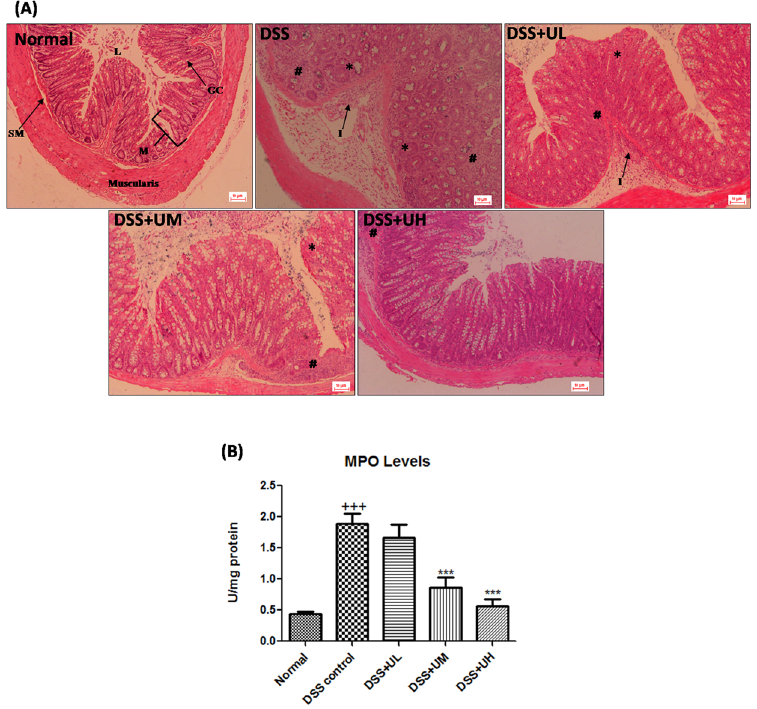
Figure 4. Effect of uridine treatment on the histopathological changes and myloperoxidase (MPO) activity of the colon tissue. ( A ) Representative images of hematoxylin and eosin staining of colon tissue from each group taken at 100x magnification. Colon tissue from Normal group did not show any pathological modification, DSS- induced colon tissue injury was associated with partial destruction of the epithelial architecture such as loss of crypts and epithelial integrity, submucosal edema and intense infiltration of inflammatory cells. Treatment with different dosages attenuated the injury of colon tissue in dose dependent manner. L, Lumen; GC, Goblet cells; M, Mucosa; SM, Submucosa; I, Inflammation; asterisk ( * ) indicates area of goblet cell depletion and distortion of crypt architecture; number sign (#) indicates cellular infiltration. ( B ) The myloperoxidase (MPO) activity in colon tissue, values are the mean ± SEM (n = 6). +++ p < 0.001 vs Normal and *** p < 0.001 vs DSS